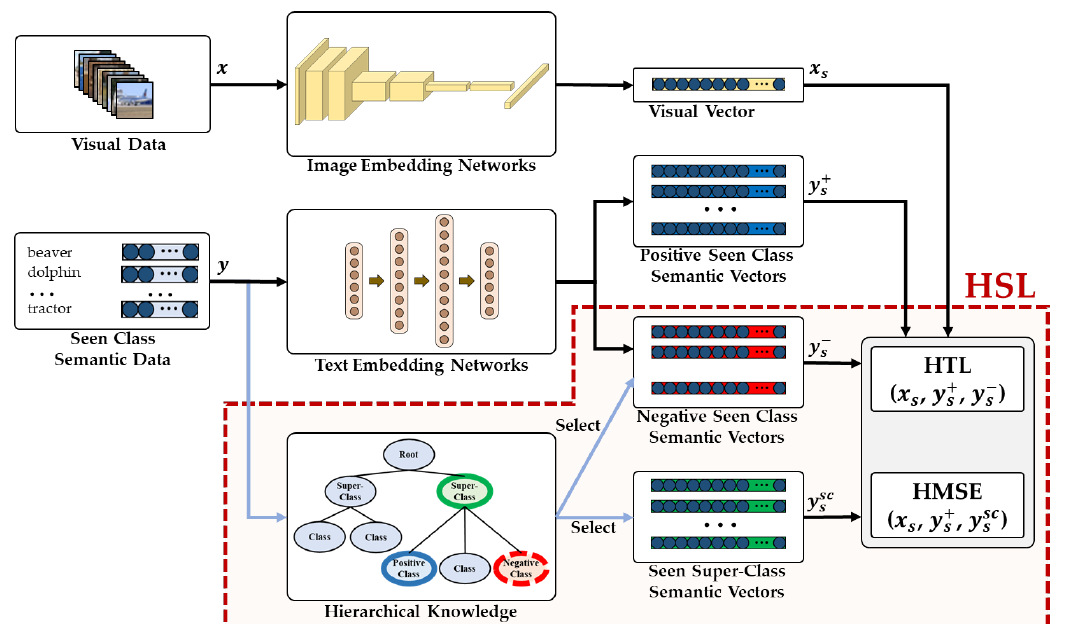
Figure 1. Zero-shot learning process with hierarchical semantic knowledge.